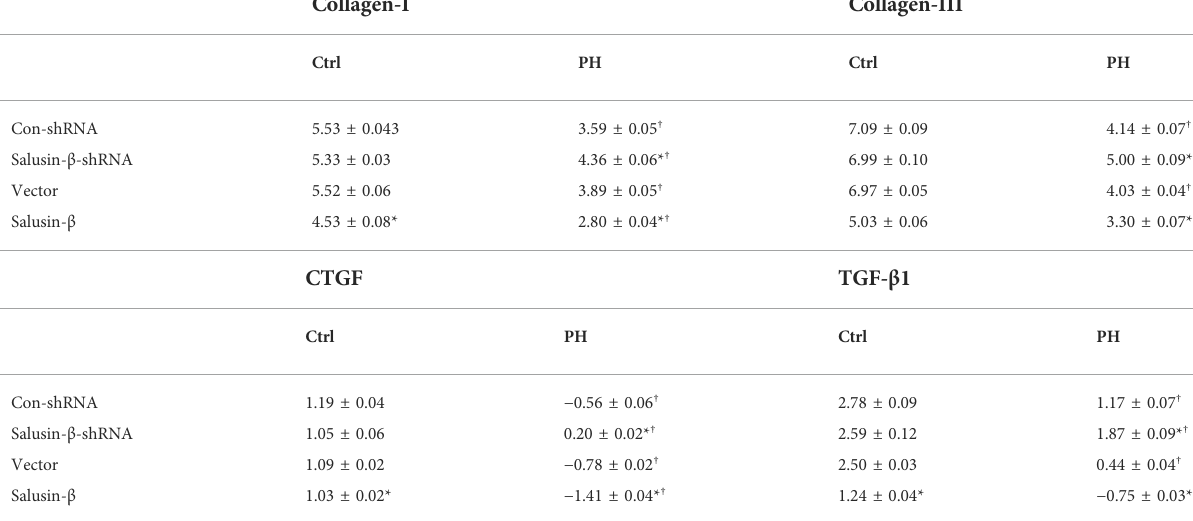
TABLE 3 The Δ CT values for Collagen-I, Collagen-III, CTGF, and TGF- β 1 during mRNA measurement using quantitative